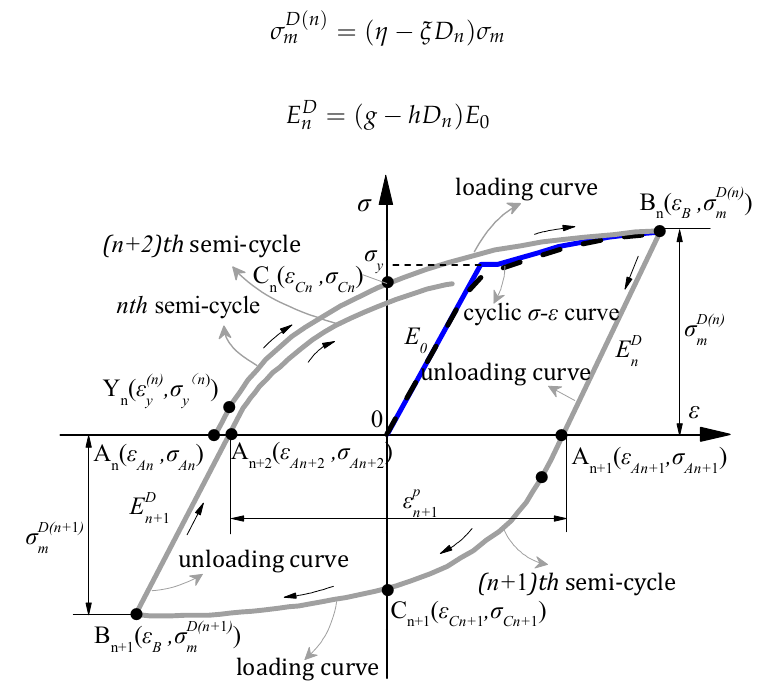
Figure 14. Hysteretic model of welding material considering cumulative damage under cyclic loading.